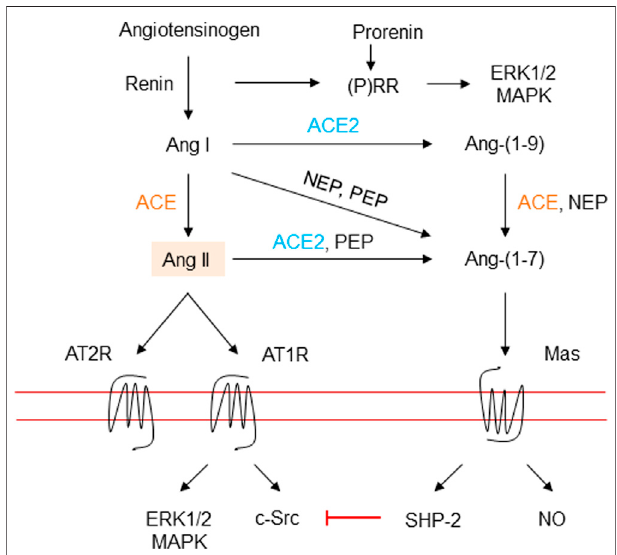
FIGURE 3 | The renin-angiotensin-aldosterone system. Renin is secreted due to various stimuli, and then cleaves angiotensinogen into the inactive decapeptide Ang I. Renin and prorenin can also interact with (pro) renin receptors to activate the MAP kinases ERK1/2 and p38 pathways. ACE cleaves Ang I into the octapeptide Ang II, or to Ang-(1 – 7) by ACE2 and probably ACE. ACE2 may also produce Ang-(1 – 7) from Ang II. ACE also inactivates bradykinin into inactive fragments. Importantly, Ang II may be generated directly from angiotensinogen through non-ACE pathways. Ang II activates AT1R, a G protein-coupled receptor. Vasoconstriction and stimulationofaldosteronetendtoelevateblood pressure.AngIIalsoactivates AT2R, a G protein-coupled receptor, which can antagonize the effects of activation of the AT1R. Ang, angiotensin; ACE, angiotensin converting enzyme; MAPK, mitogen-activated protein kinase; extracellular signal regulated kinase, ERK; angiotensin II type 1 receptor, AT1R; angiotensin II type 2 receptor, AT2R; (P)RR, (pro)renin receptor; c-Src, cellular Src kinase, a non-receptor tyrosine kinase; SHP-2, Src-homology 2